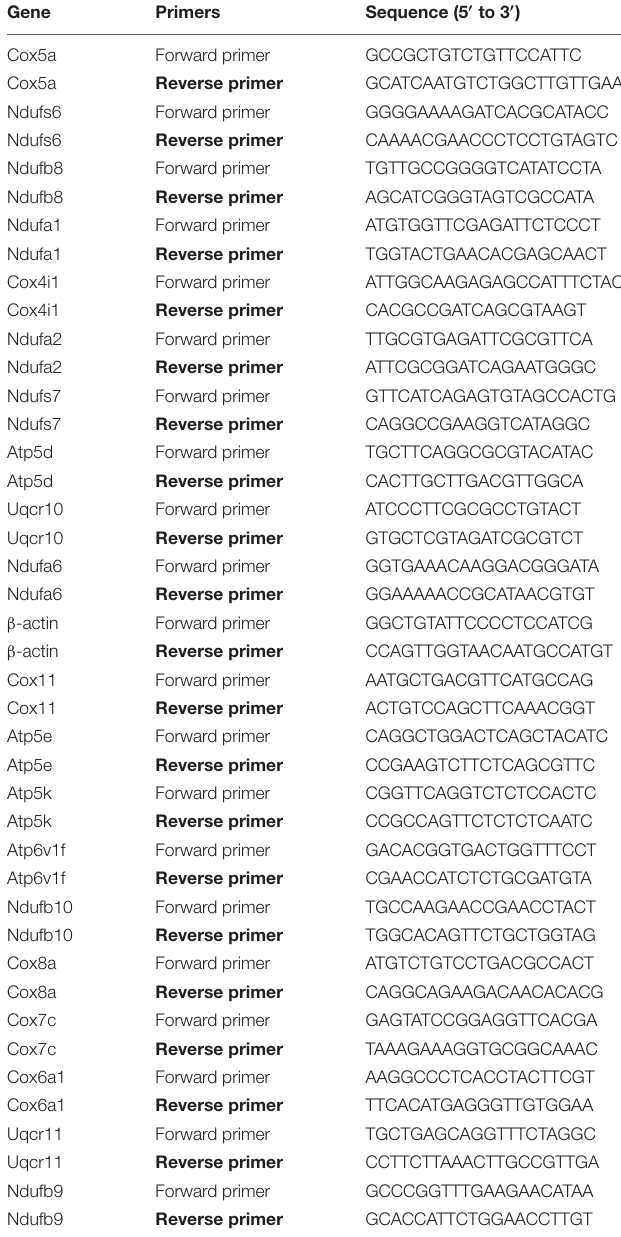
TABLE 1 | The forward and reverse primers for Quantitative PCR (qPCR) detection.